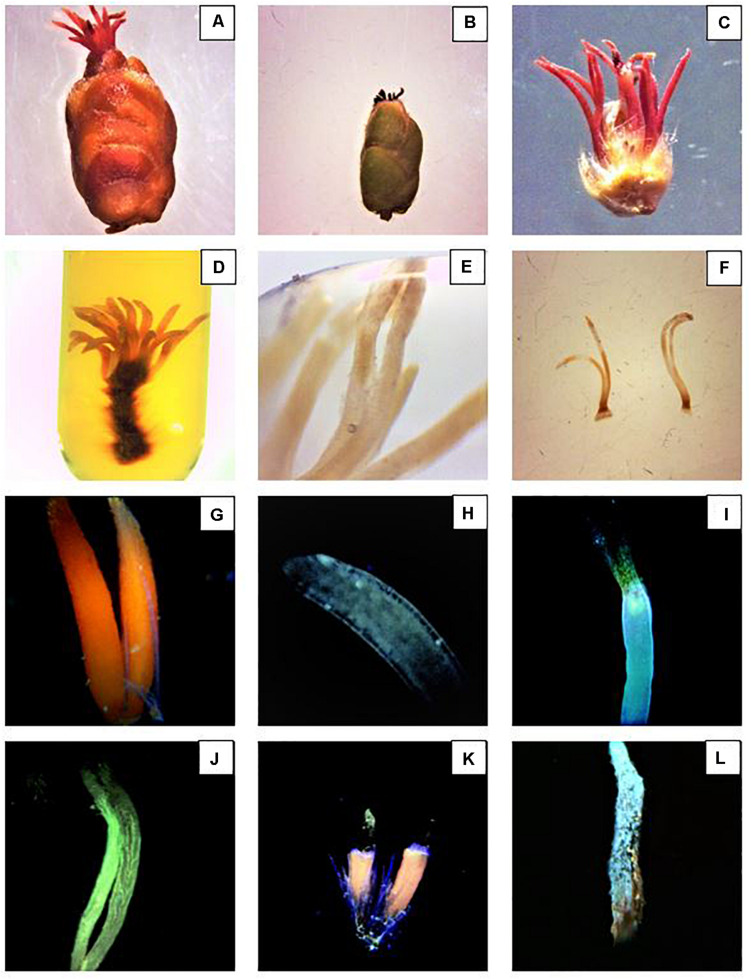
Preparation and examination of the stigmatic styles. (A) Hazelnut female inflorescence in R8 stage. (B) Female inflorescence after dust application. (C) Structure of the female inflorescence after bud dissection. (D) Stigmatic styles soaked in 5 M NaOH solution after 2 days. (E) Stigmatic styles soaked in 5 M NaOH solution after 3 days. The bleaching phase is a fundamental step to properly visualize the pollen tubes. (F) Samples ready to be squashed in aniline blue. (G,H) Healthy non-pollinated stigmatic styles. (I) Top of the style withered and the pollen tube curled and arrested at the top part of the style. (J) Pollen tubes reached the base of the styles. (K) Damaged stigmatic styles covered with dust. (L) Pollen grains siting on a dried style after dust application.